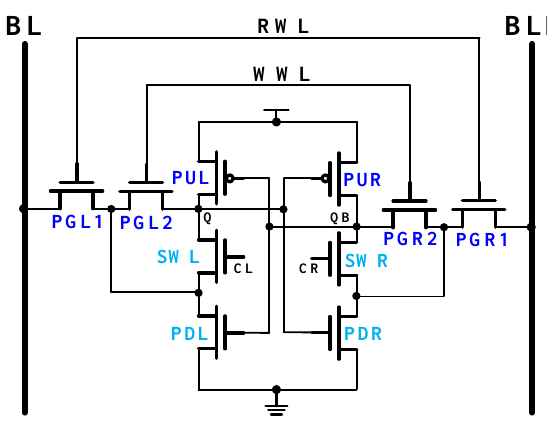
Figure 1. The proposed 10T SRAM bit-cell design.